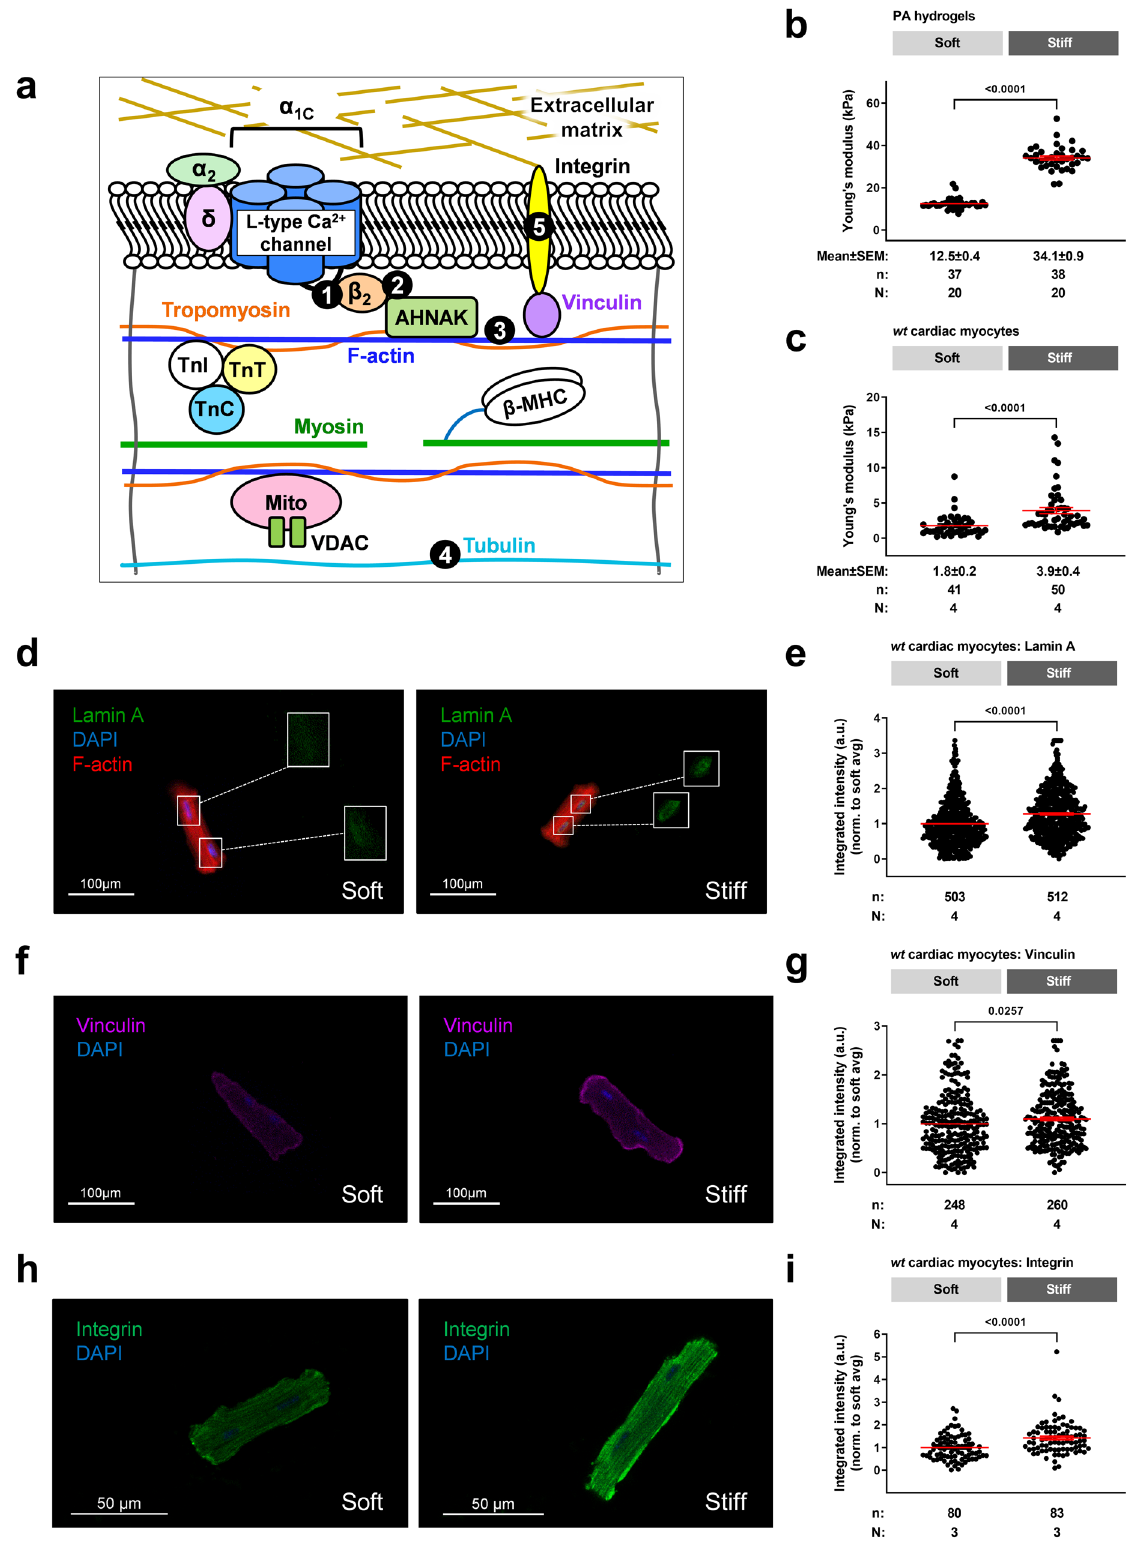
performed in mouse and guinea pig cardiac myocytes demon- strate that activation of the LTCC by voltage-clamp of the plasma membrane, application of high K + solution or BayK( − ), results in an increase in Ψ m , even in the absence of calcium 9 . Depolymerization of actin or β -tubulin with Latrunculin A or colchicine, or the absence of dystrophin, attenuates elevated Ψ m